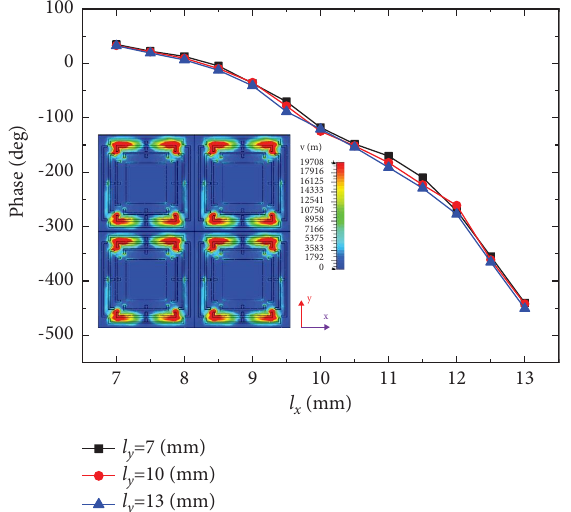
Figure 5: Surface electric feld and phase characteristic curves of the unit cell.